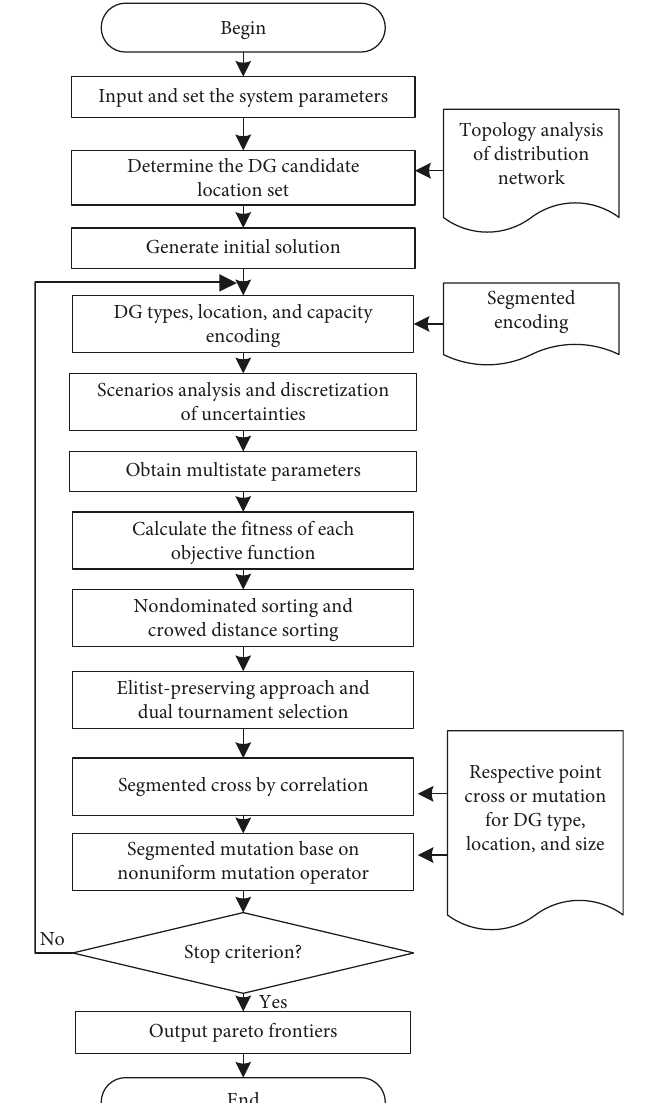
Figure 3: Flowchart for multiobjective